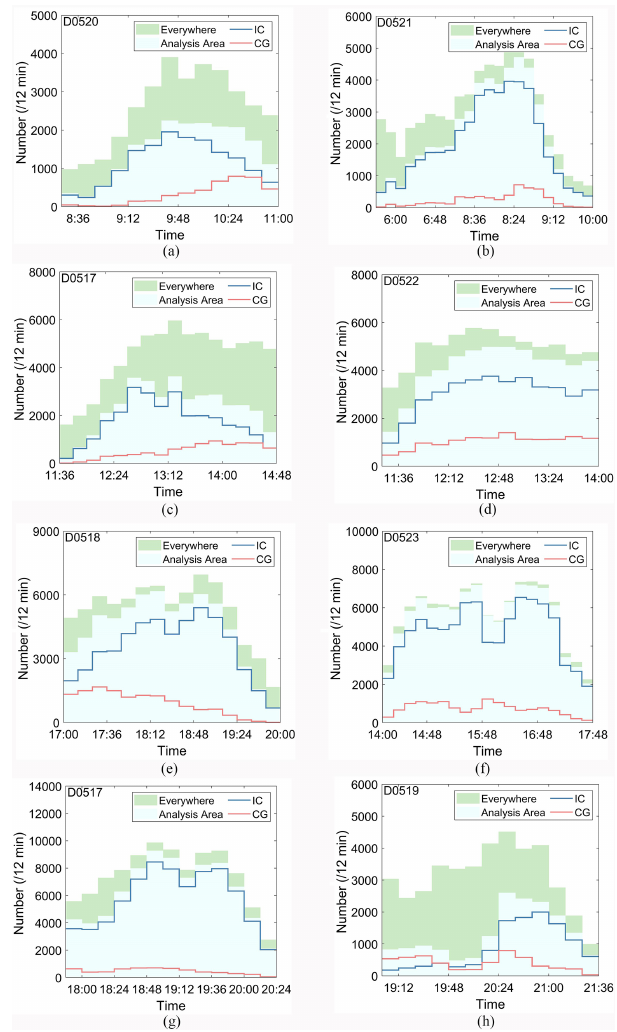
Figure 4. (a–h) Lifetime diagrams of total lightning events for thunderstorm case study from 17 to 23 May. The green shaded areas represent all lightning events detected by the LLS network, whereas the light blue shaded areas represent total lightning events produced by the chosen thunderstorm. The blue and red lines indi- cate the number of IC events and CG events with respect to time per 12min,